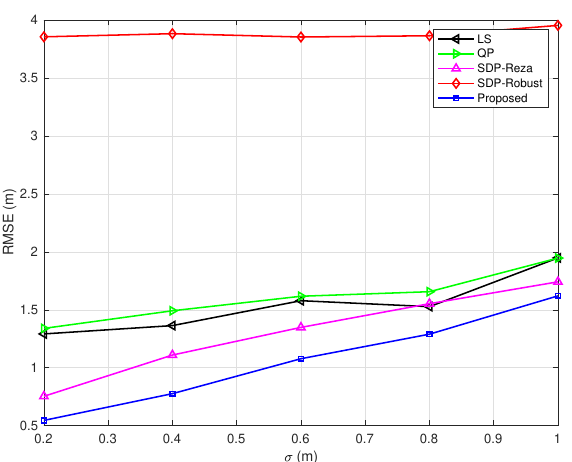
Figure 4. RMSEs vs. σ ( B max = 10 m and the number of NLOS links equals 2 ) .